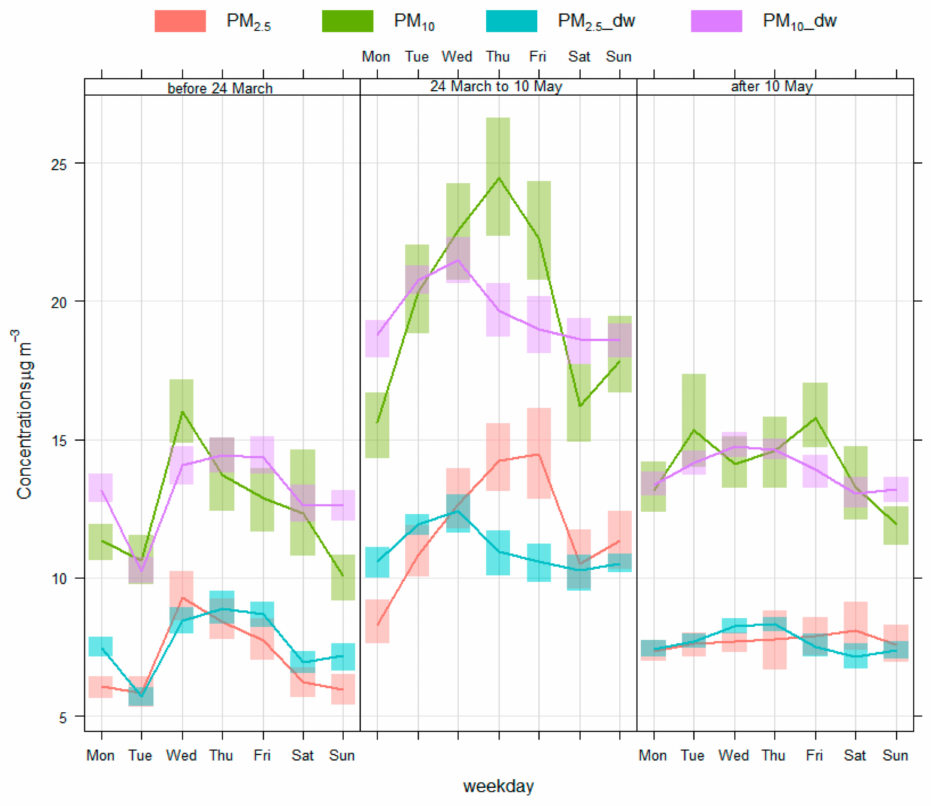
Figure 5. Weekly cycles of PM 2.5 and PM 10 for pre-lock down, lock-down, and post-lockdown periods at Devonshire Green AQMS in